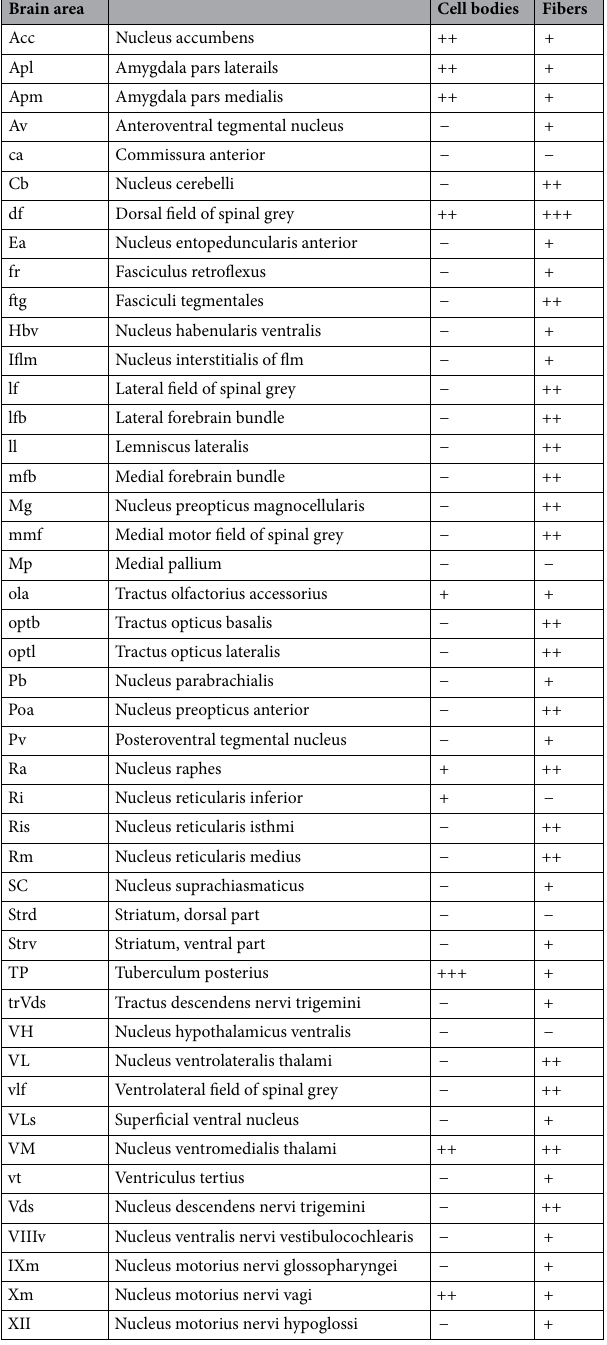
Table 1. Localization of gastrin-releasing peptide (GRP)-immunoreactive cell bodies and fibers in Xenopus central nervous system. The relative density of labeling was classified as low (+), moderate (++), and high (+++). LV lateral ventricle, 3 V third